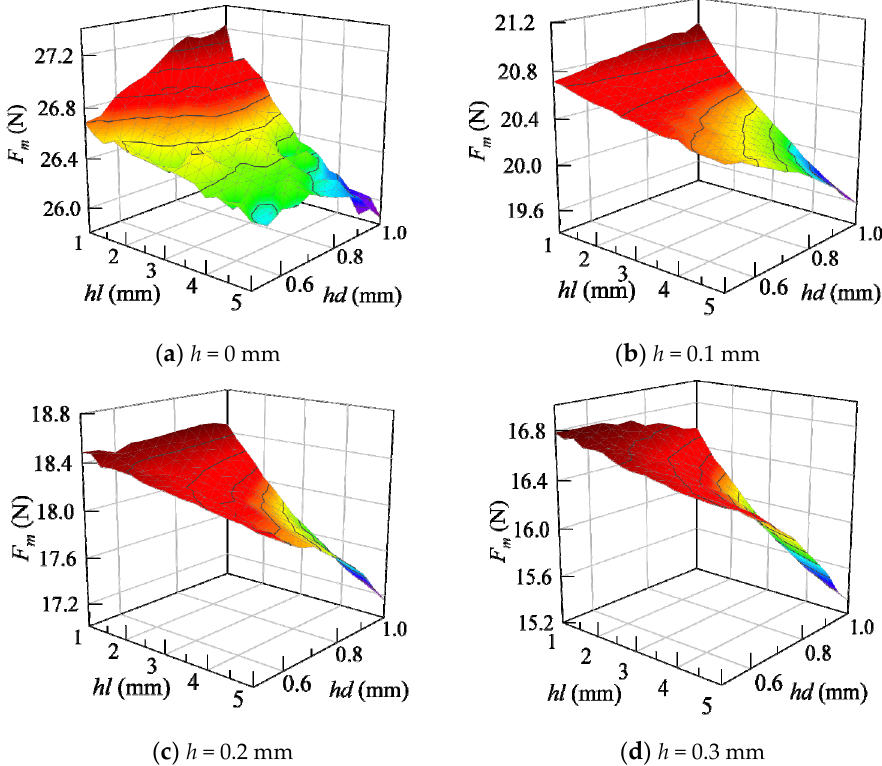
Figure 13. Static electromagnetic force along with opening radius and depth.